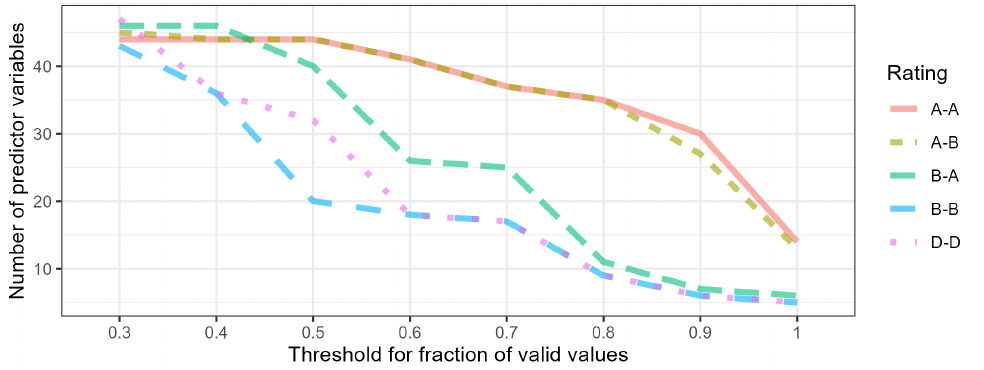
Figure 3. Counts of predictor variables for various threshold values of valid data